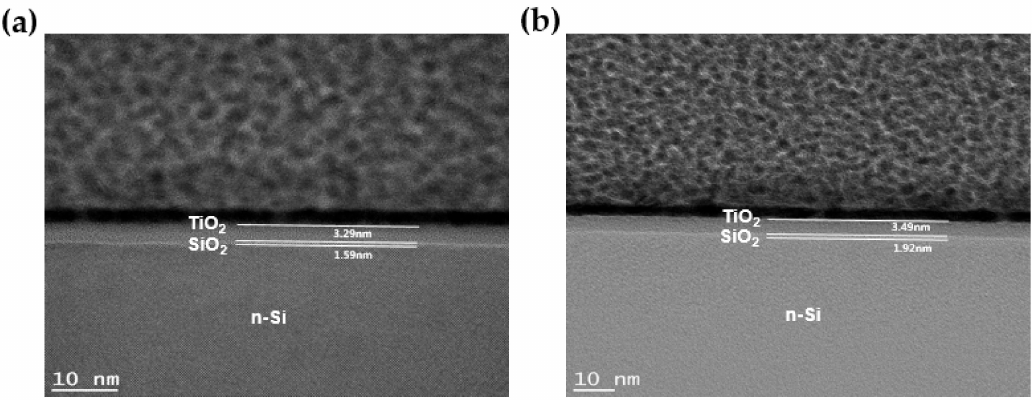
Figure 6. HR-TEM image of Si / SiO 2 / TiO 2 stacks prepared by ( a ) ALD and ( b ) thermal